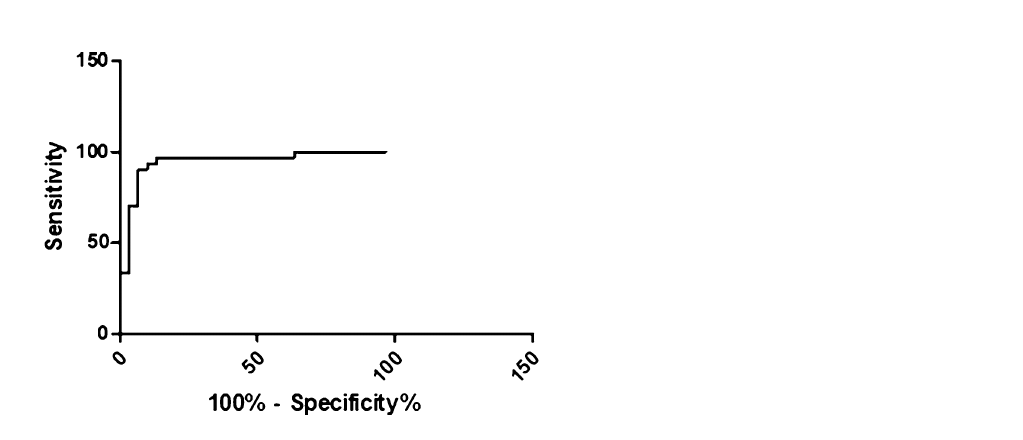
Figure 1. Western blot analysis of SCA and S. mansoni positive and negative sera.